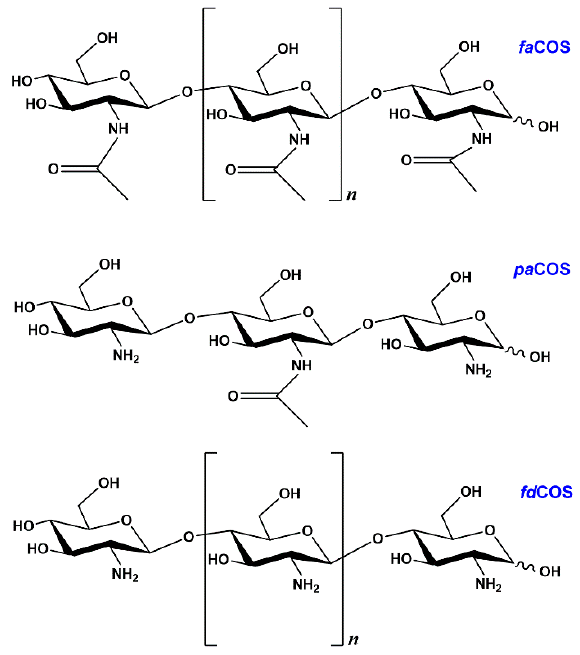
Figure 1. Structure of the three main types of chitooligosaccharides (COS): fully acetylated ( fa COS), partially acetylated ( pa COS), and fully deacetylated ( fd COS).